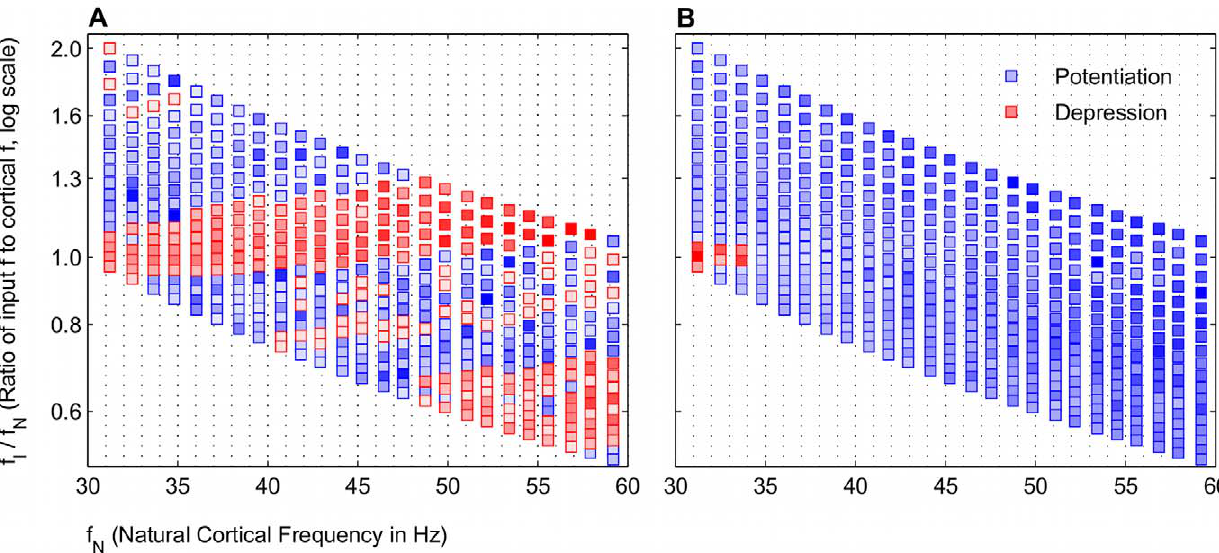
Figure 13. Frequency maps for symmetrical windows show nearly complete potentiation for all frequency regimes. Conductances are averaged around window w ~ 100 ms to calculate potentiation and depression. Potentiation is shown in blue, and depression is shown in red. (A) Temporally asymmetric windows. A z ~ 5 : 0x10 { 3 , A { ~ 2 : 5x10 { 3 , t z ~ 14 ms , and t { ~ 34 ms . (B) Temporally symmetric windows, with the same amplitudes as (A) but with t z ~ t { ~ 20 ms . 443/450 shown frequency regimes potentiated in these